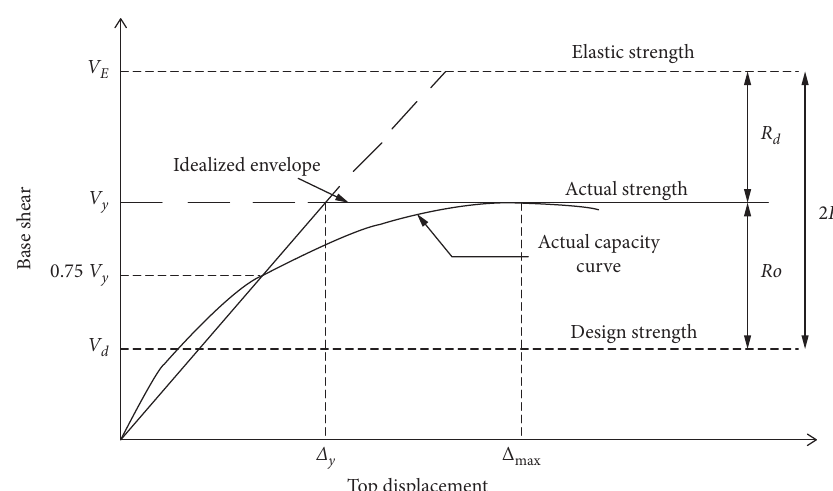
Figure 3: Interrelation between response reduction factor, overstrength factor, and ductility reduction factor [23,